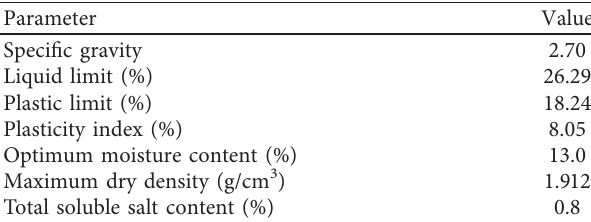
Table 1: Physical properties of the loess.